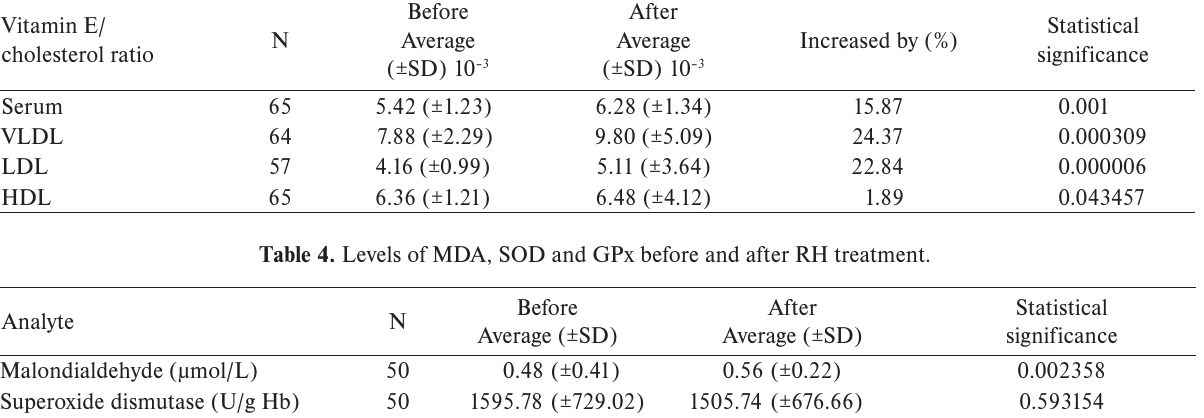
Table 3. Vitamin E/cholesterol ratios in serum and lipoprotein fractions before and after RH treatment. Vitamin E/ cholesterol ratio